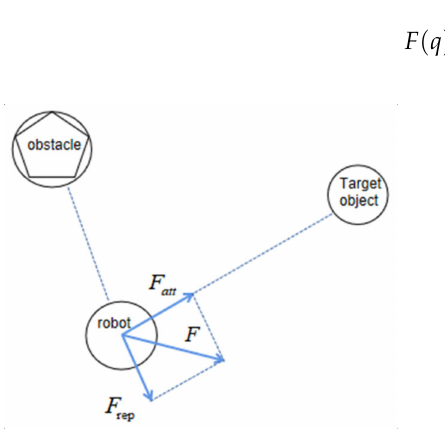
Figure 1. Diagram illustrating the principle of the APF method.